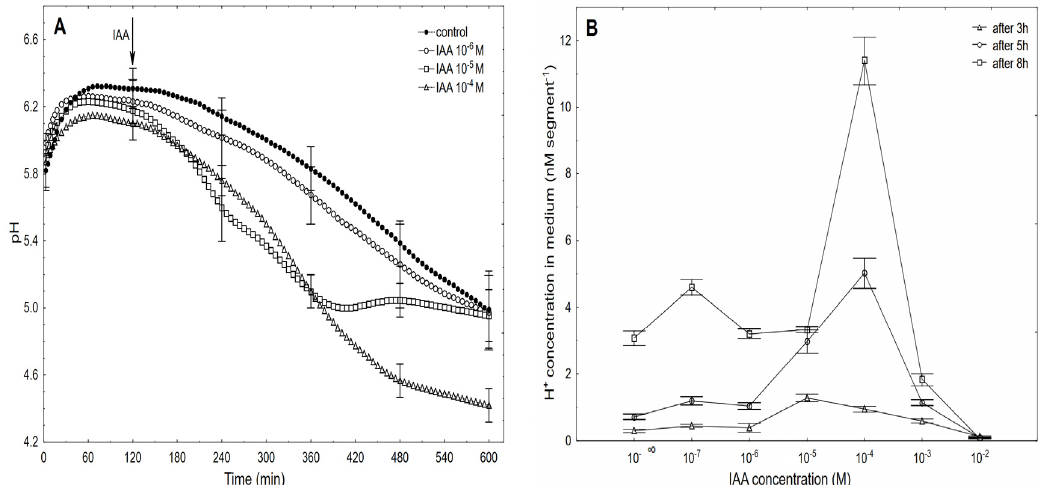
Figure 4. Kinetics of the medium pH changes of the coleoptile segments that had been incubated in the presence of 10 –6 , 10 –5 and 10 –4 M of the IAA ( A ) and dose-response curves for the IAA (10 –7 –10 –2 M)-induced medium pH changes (expressed as changes in the H + concentration per coleoptile segment) of the coleoptile segments as a function of time ( B ). The coleoptile segments were first preincubated (over 2 h) in an auxin-free medium to which the IAA was added (arrow). The pH values are the means of at least six independent experiments that were performed simultaneously with growth (shown in Figure 3) using the same tissue samples. Bars indicate ± SE.